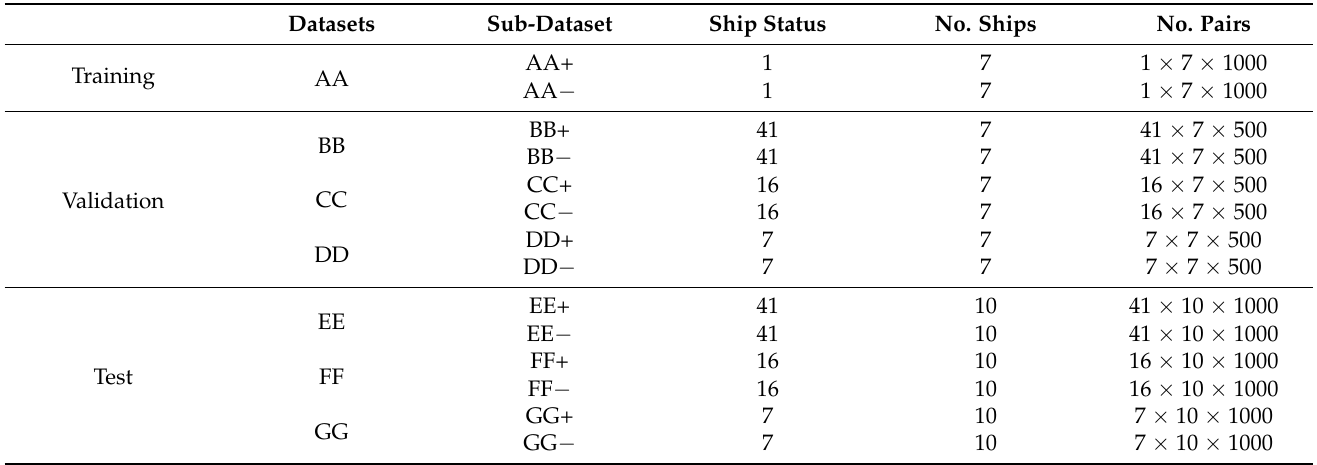
Table 2. The dimensions of positive and negative sample pairs.